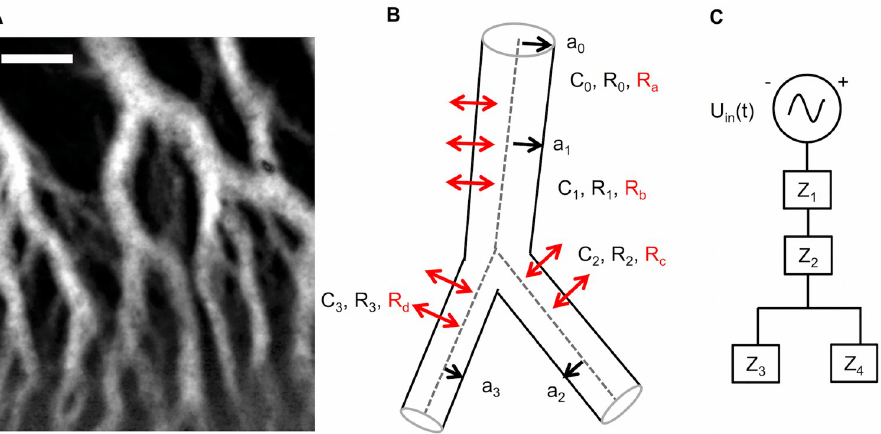
Fig 9. Modeling internal veins as an equivalent electrical circuit. A) Time series (standard deviation) of a mesoplasmodial internal vein network. Scale bar = 50 μ m. B) Model of branching vein. Each branch has its own characteristic length, radius and resulting fluidic resistance and capacitance. C) The branching vein, drawn as an electrical circuit. It consists of 4 single 3-element Windkessels (Z1—Z4).